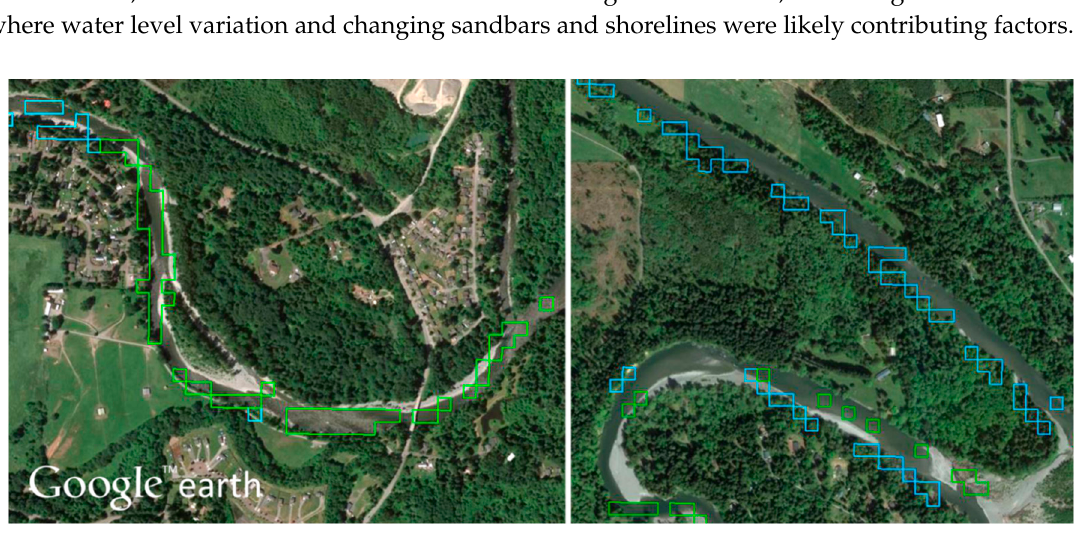
Figure 8. Green polygons correspond with pixels LC Trends interpreters had classified as Forest and CCDC classified as Water; blue polygons correspond with pixels LC Trends interpreters classified as Water and CCDC classified as Forest.